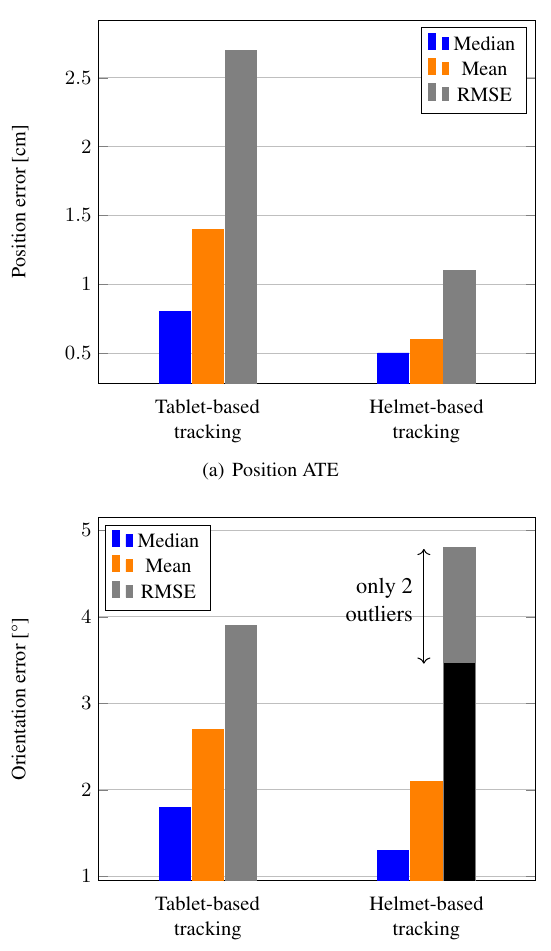
Figure 7. Evaluation results averaged over five recorded trajecto- ries for tablet-based and helmet-based tracking, respectively.